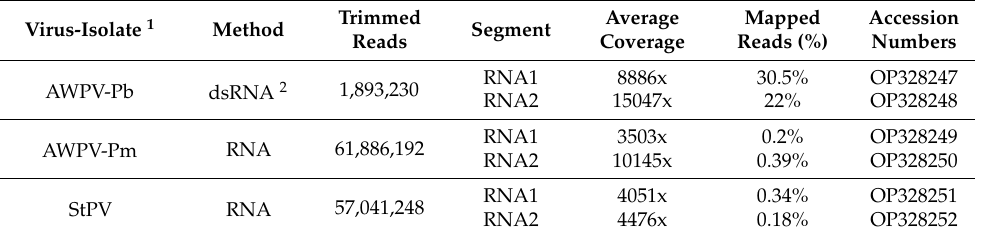
Table 1. Target nucleic acids population, number of trimmed reads, average coverage and percentage of total reads mapping to the genomic RNAs of alpine wild prunus virus (AWPV) and stocky prune virus (StPV).